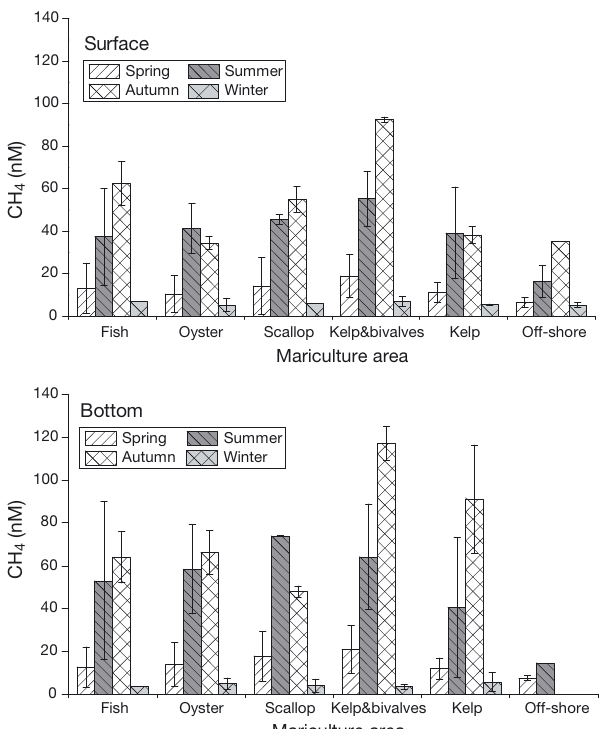
Fig. 9. Comparison of seasonal mean (±SD) CH 4 concentra- tions in surface and bottom waters in different culture areas of Sanggou